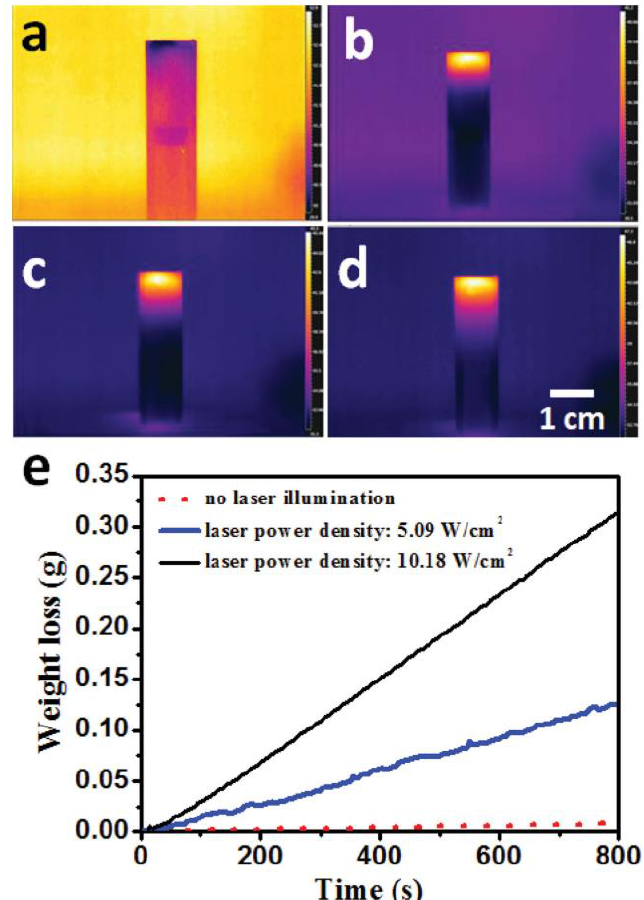
Figure 25. ( a – d ) IR images of gold nanofluid evaporation under irradiation laser illumination, and ( e ) evaporation rate under different laser power densities [90]; 2014, Wiley. Energies 2020 , 13 , x FOR PEER REVIEW